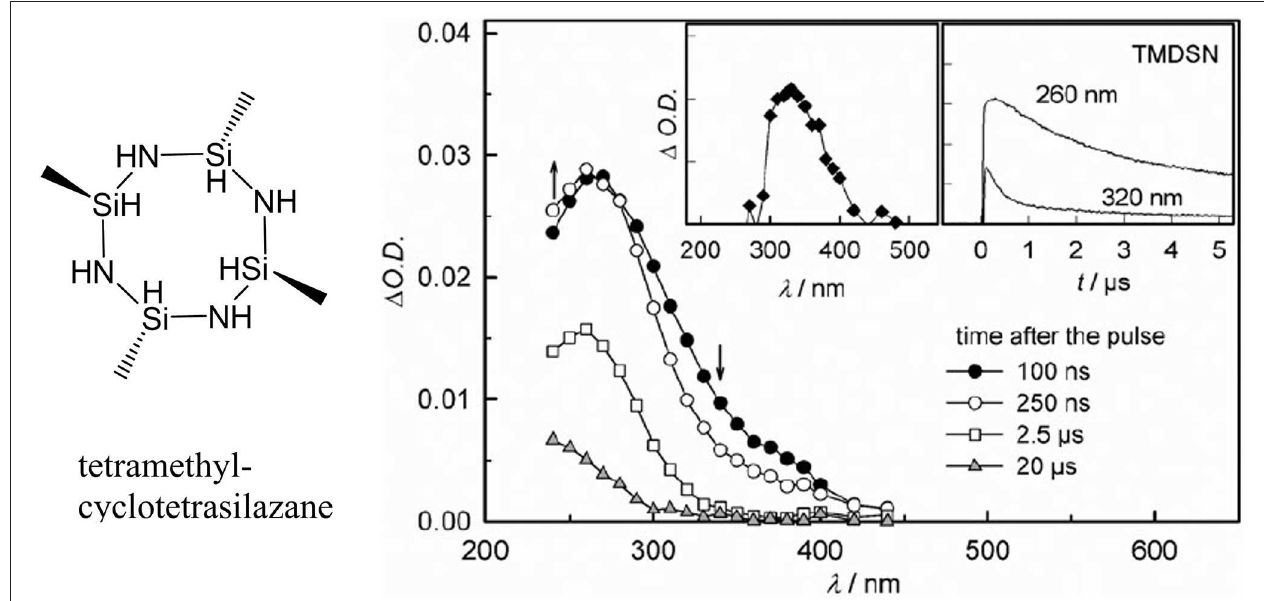
FIGURE 7 | Transient spectra observed after laser flash photolysis of an N 2 -saturated solution of tetramethylcyclotetrasilazane (molecular structure displayed on left side) (Knolle et al., 2010).